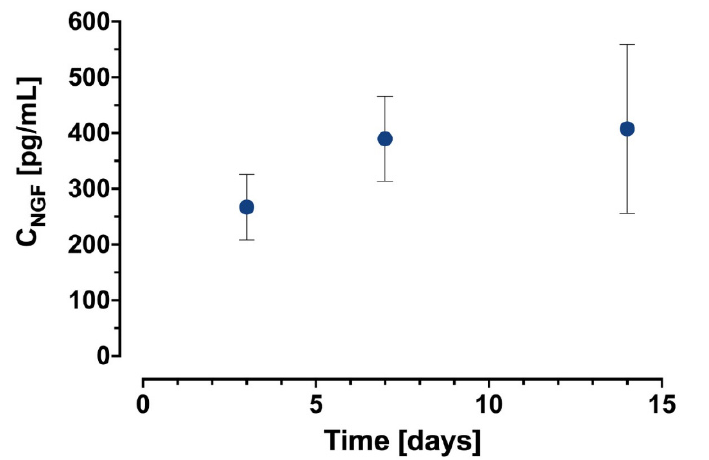
Figure 3. Cumulative release profile of NGF (pg/cm of NGF-µS/PCL helix) over a 14 day period from µS/PCL helix.